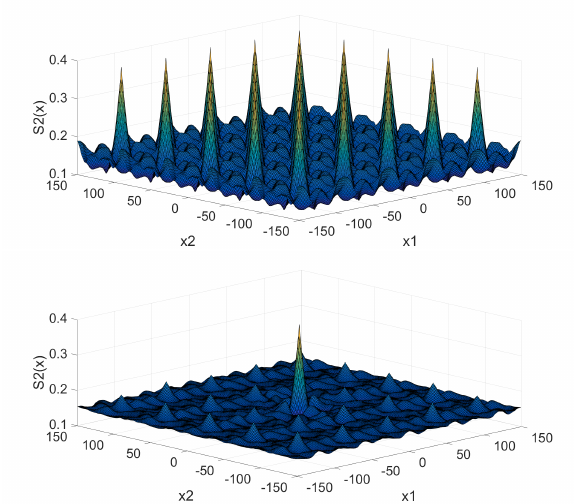
Figure 6. Two point probability function:36 inclu- sions/tile – top PUC tiling, bottom Wang